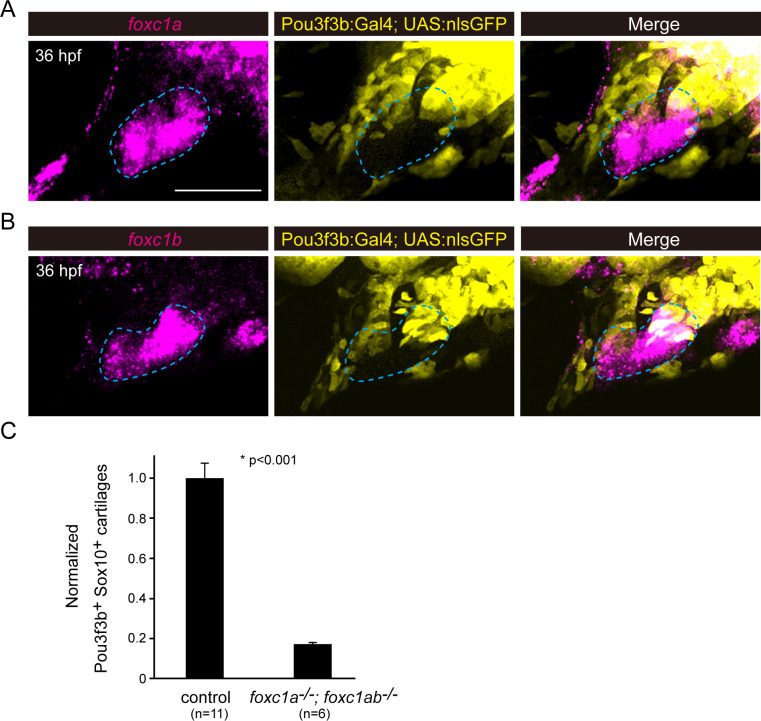
Overlapping expression of foxc1a and foxc1b with pou3f3b>GFP in the dorsal-intermediate arches.(A,B) In situ hybridization of foxc1a or foxc1b with pou3f3b:Gal4; UAS:nlsGFP (pou3f3b>GFP, detected by anti-GFP antibody) at 36 hpf. Dashed lines indicate regions of foxc1a or foxc1b expression, carried over to the pou3f3>GFP-only and merged images for reference. Scale bar = 100 μm. (C) Quantification of pou3f3b>GFP+; sox10:DsRed+ cartilage size in control and foxc1a–/–; foxc1b–/– mutant embryos at 6 dpf. Units were normalized to one based on the average size of the control cartilage. n indicates number of embryos analyzed. Shown is mean ± sem, and p value was calculated using Students’ T test (tails = 2, type = 3).